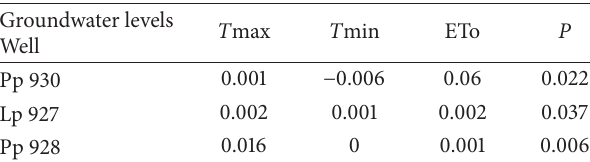
Table 1: The coefficient of correlation between groundwater levels temperature ( T max, T min), evapotranspiration (ETo), and precipi- tation ( 𝑃 ).